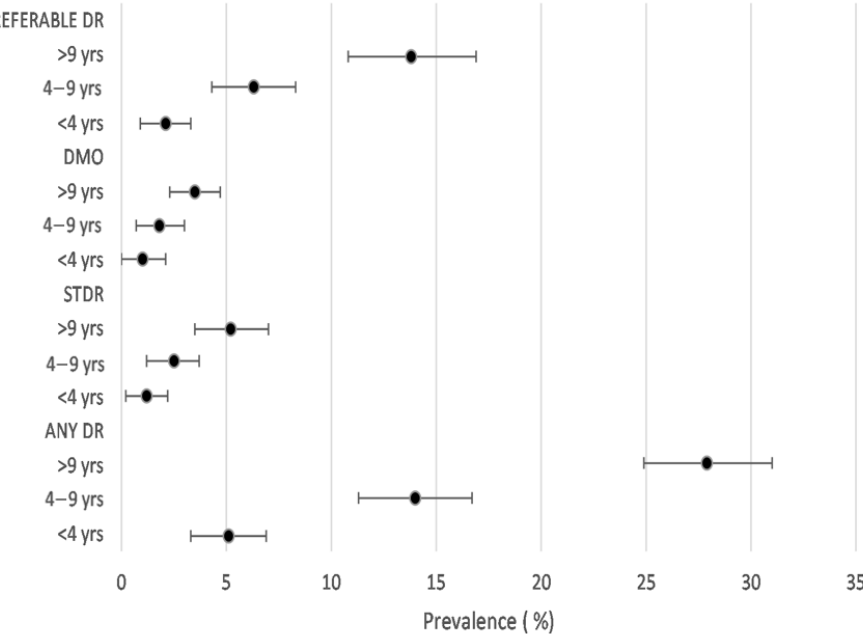
Figure 2. Age- and sex-standardised prevalence of DR outcomes according to duration of diabetes. Table 7. Associations of DR with mutually adjusted socio-demographic and diabetes-related factors ( N =